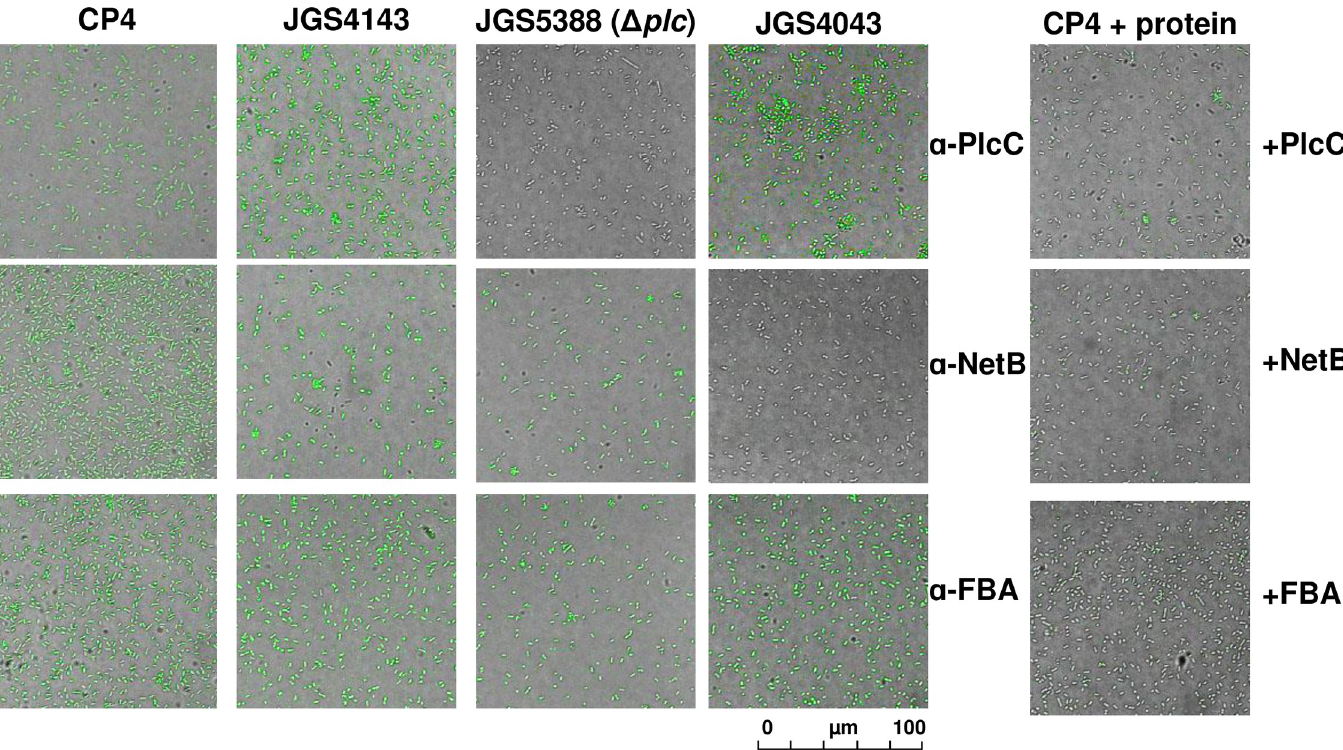
Fig 5. Indirect immunofluorescence detection of proteins on the surface of C . perfringens . The strains we used were virulent strains CP4 and JGS4143, strain JGS5388, a Δ plc derivative of JGS4143 and NetB - strain JGS4043. C . perfringens strains were incubated with polyclonal sera from rabbits hyperimmunized with the indicated C . perfringens proteins. In the far-right panel, sera were mixed with 1 μ g of the indicated proteins for 30 min prior to incubation with the C . perfringens strains.